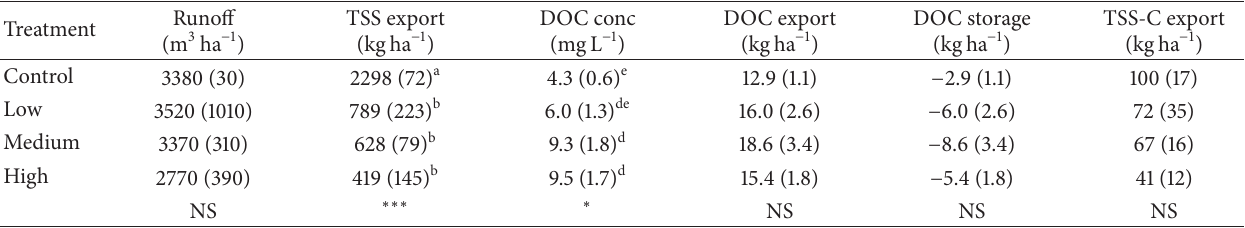
Table 1: Biomass effect on runoff, TSS, DOC, and TSS-C in the short (91m long) field. Shown are means (standard error). 𝑛 = 3 . Treatment